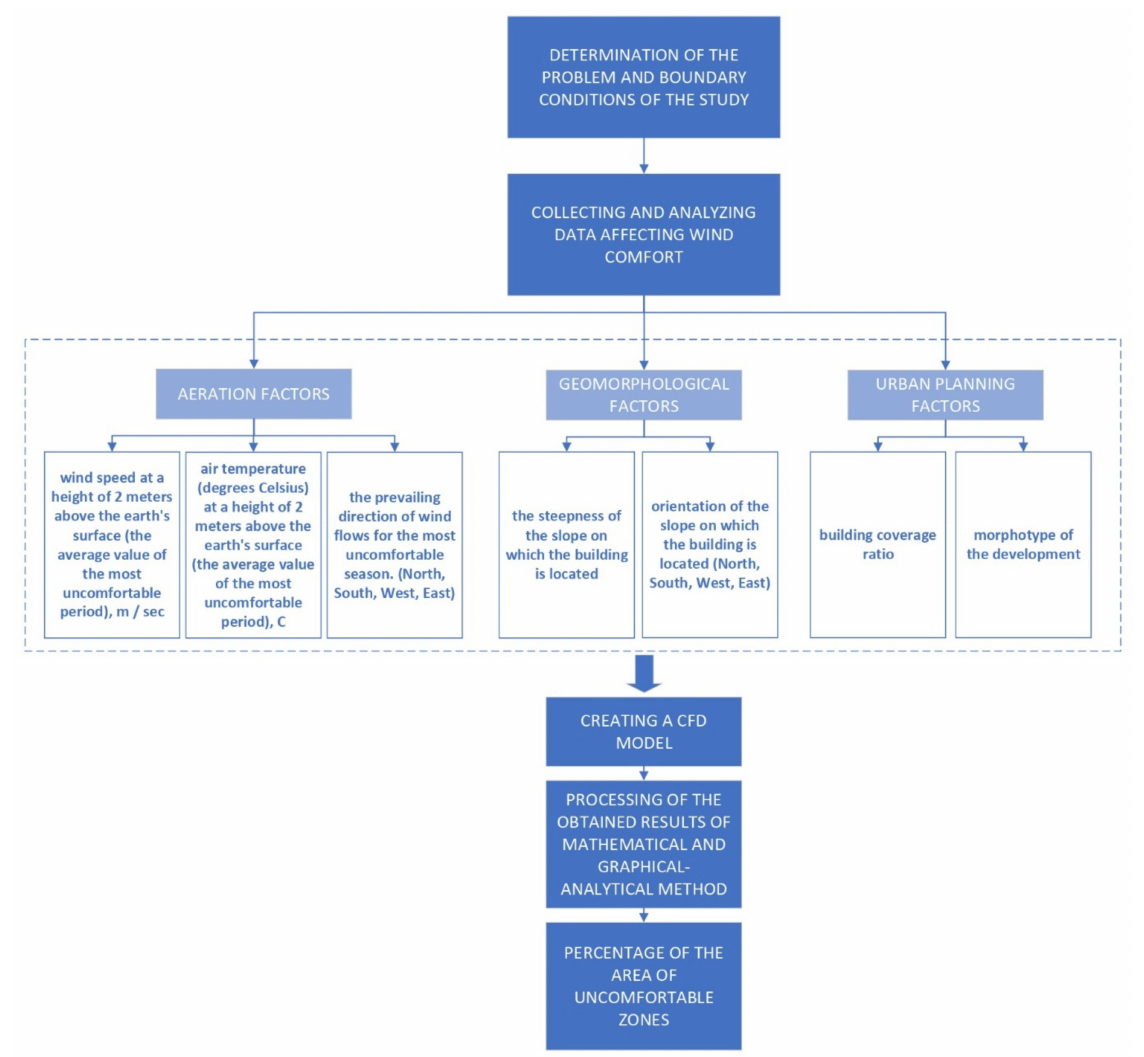
Figure 2. Methodological fluxogram of the